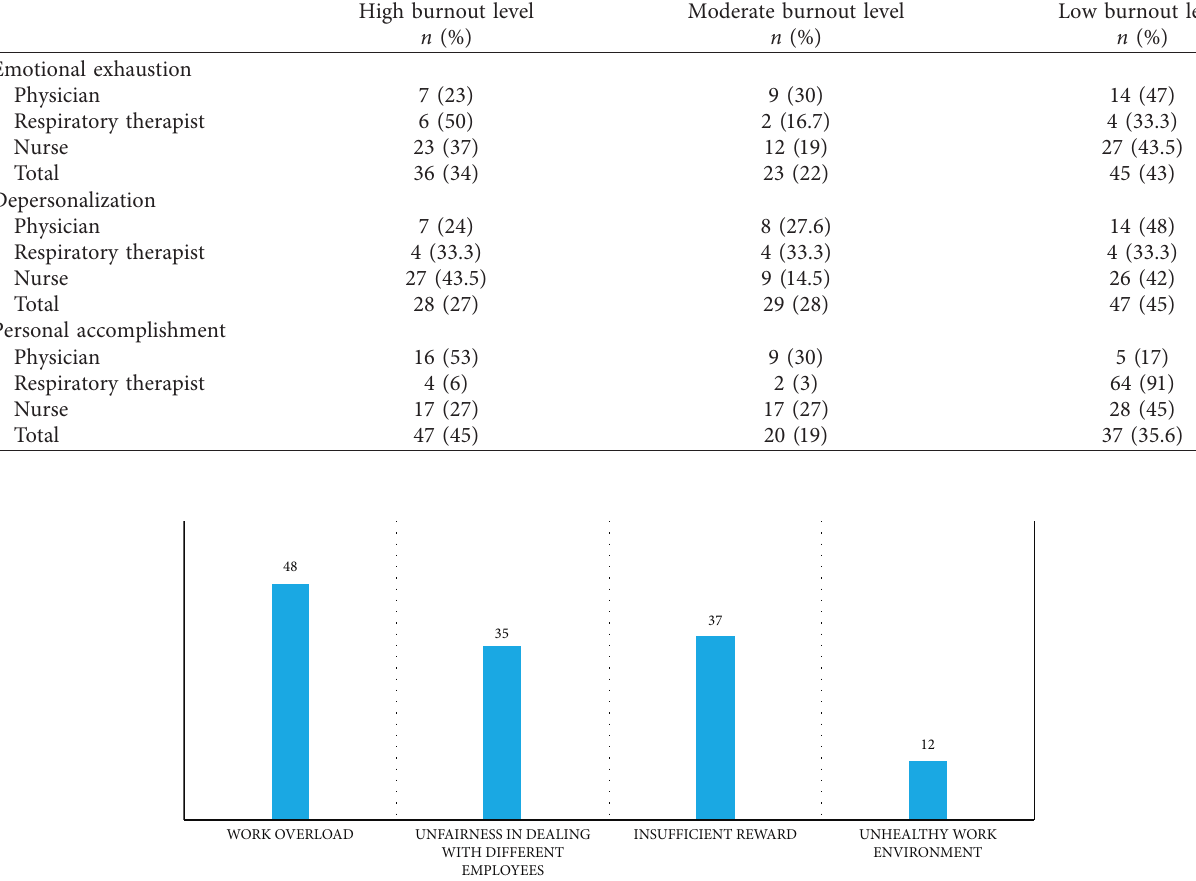
Table 3: Interpretation of MBI subscale scores for ICU staff ( N � 104).